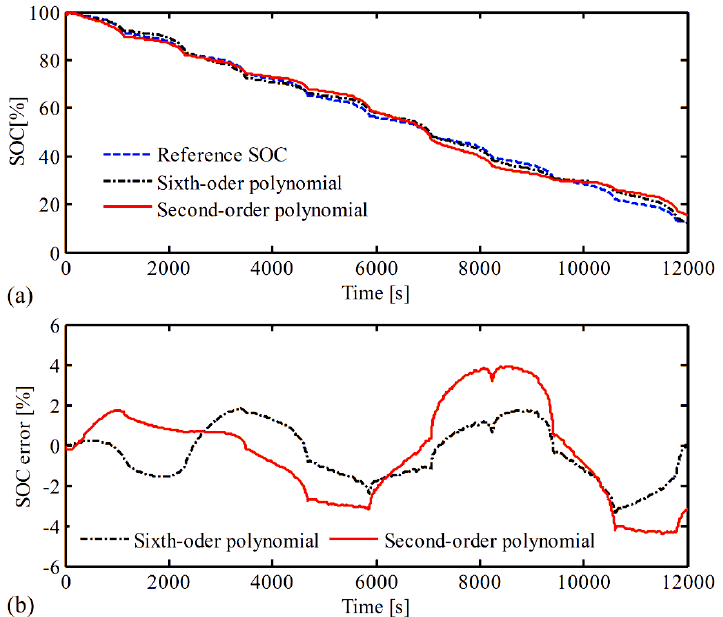
Figure 13. SOC estimation with AGNO based on different OCV - SOC relationships under NEDC test: ( a ) SOC ; and ( b ) SOC